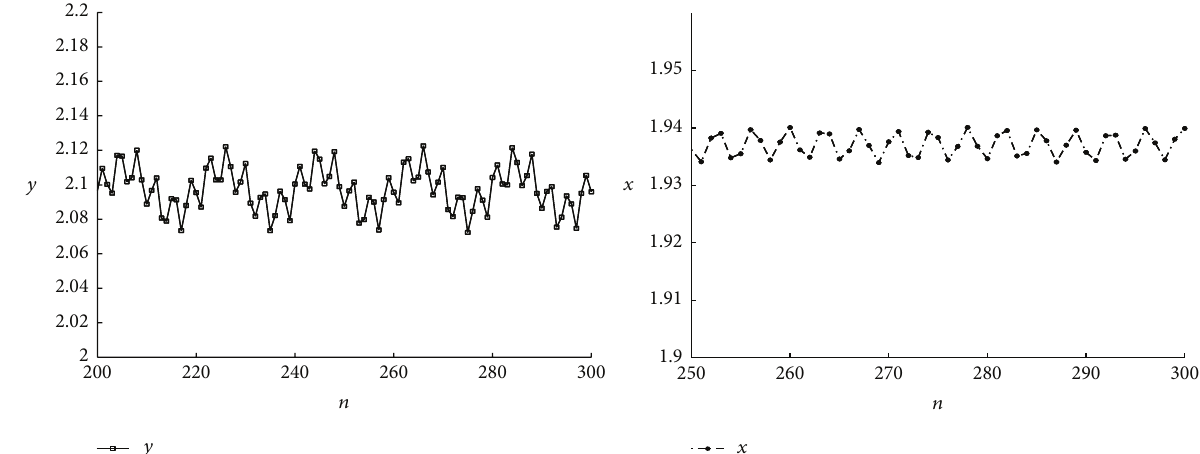
Figure 2: Almost periodic solution (𝑥(𝑛),𝑦(𝑛)) of system (2) with initial conditions (𝜑(𝜃),𝜓(𝜃)) = (0.1, 0.3), (0.3,0.1),(0.2, 0.3) for 𝜃 = −2, −1,0 ,